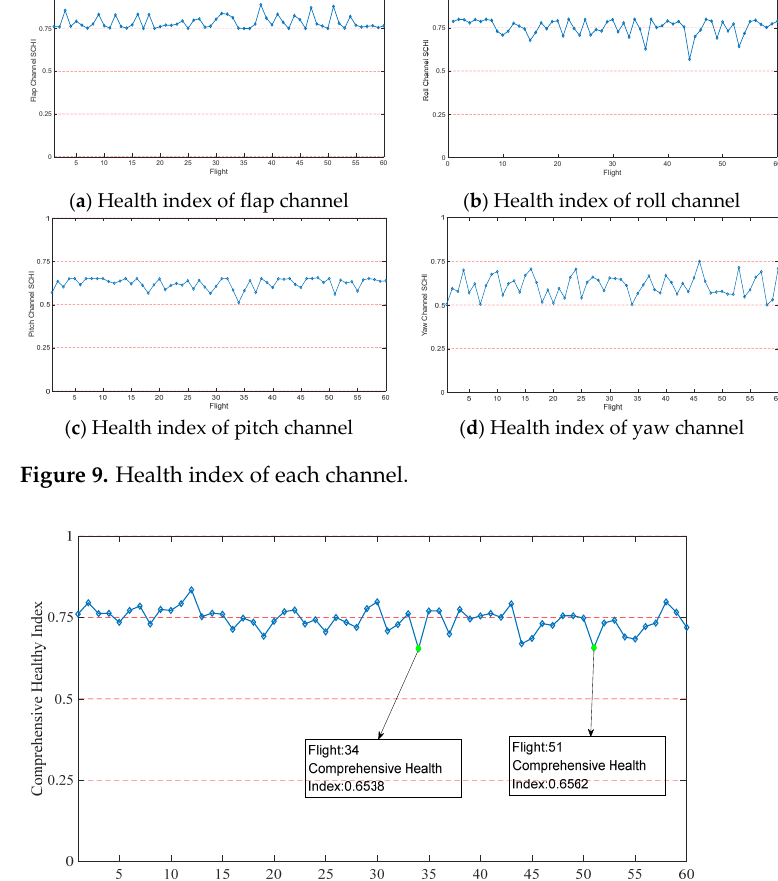
Figure 10. Health index of flight control system.